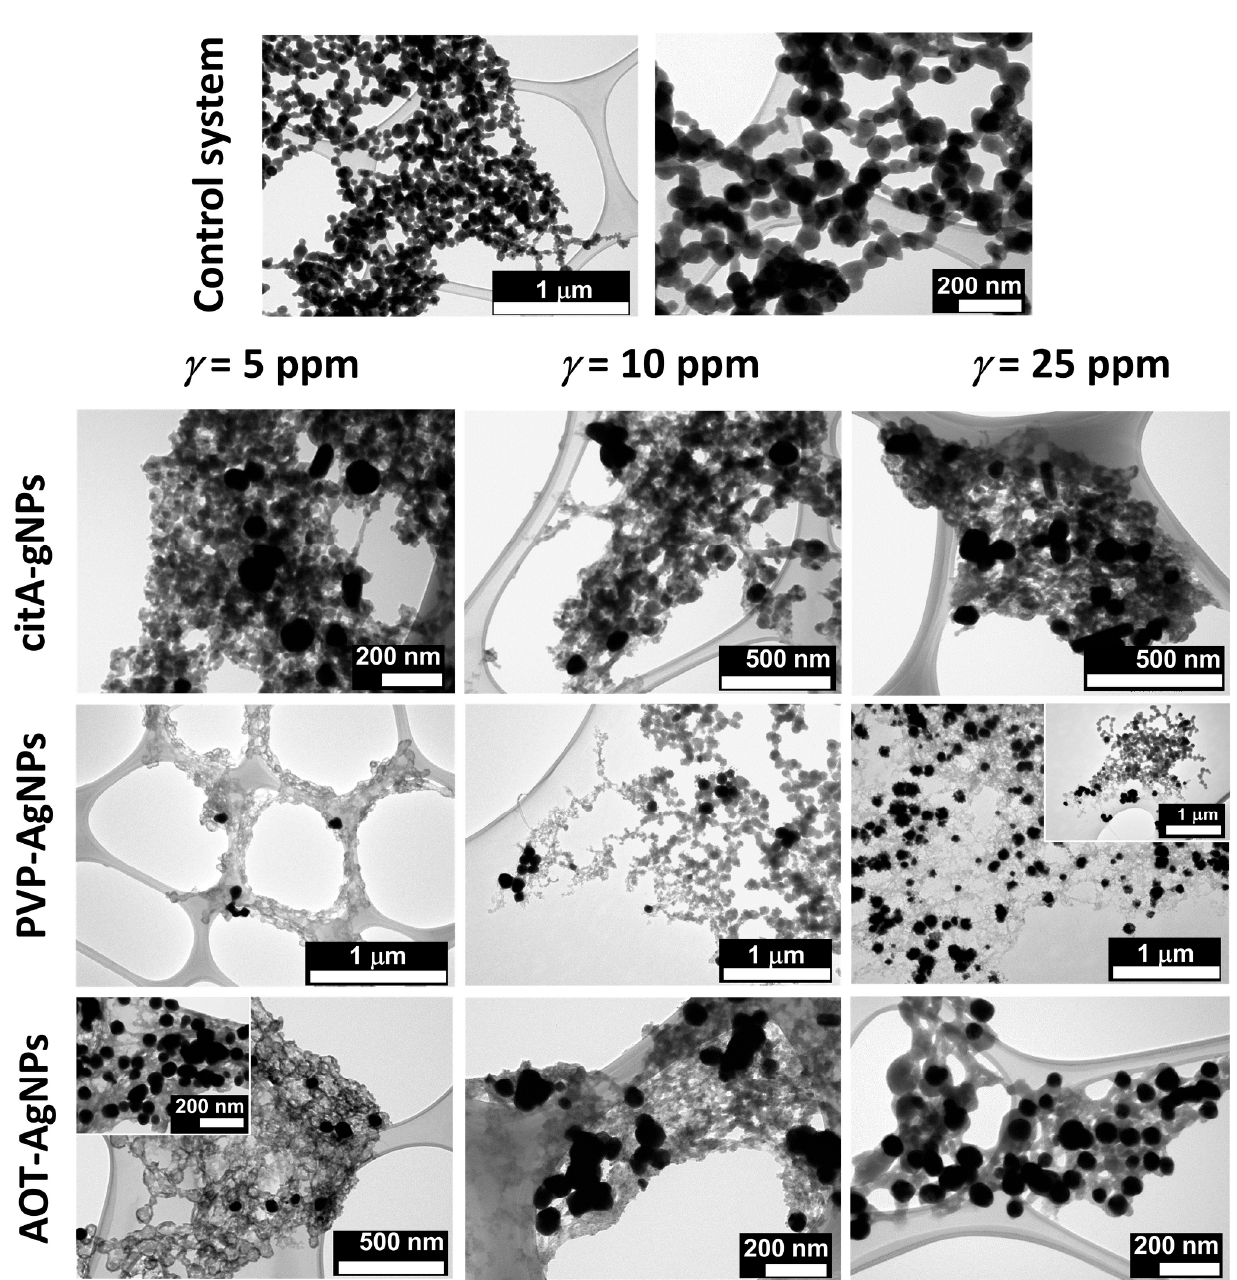
Figure 6. TEM micrographs of precipitates obtained after 10 min reaction time in the control system and in the presence of different concentrations of silver nanoparticles (AgNPs) stabilized with citrate (cit-AgNPs), poly(vinylpyrrolidone) (PVP-AgNPs), and sodium bis(2-ethylhexyl) sulfosuccinate (AOT-AgNPs). c (CaCl 2 ) = c (Na 2 HPO 4 ) = 4 · 10 − 3 mol dm − 3 , pH 7.4, 25 °C.